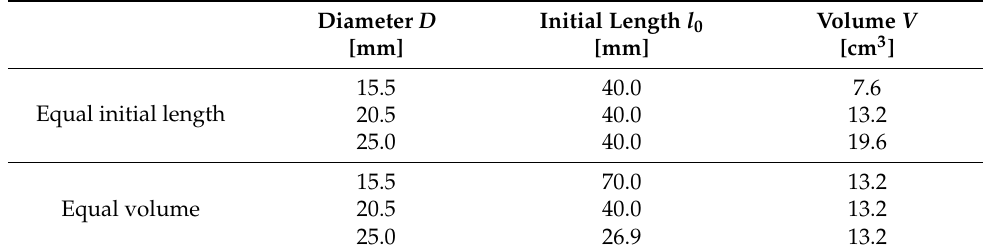
Table 1. Dimensions of Composite Cores used in Tube